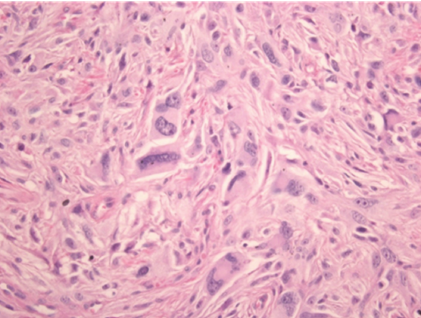
Figure 1: Microscopic view (400x) of the tumor of the right upper leg. The histopathological pattern, immunoprofile, and localization of this subcutaneous tumor favor the diagnosis of DFSP.